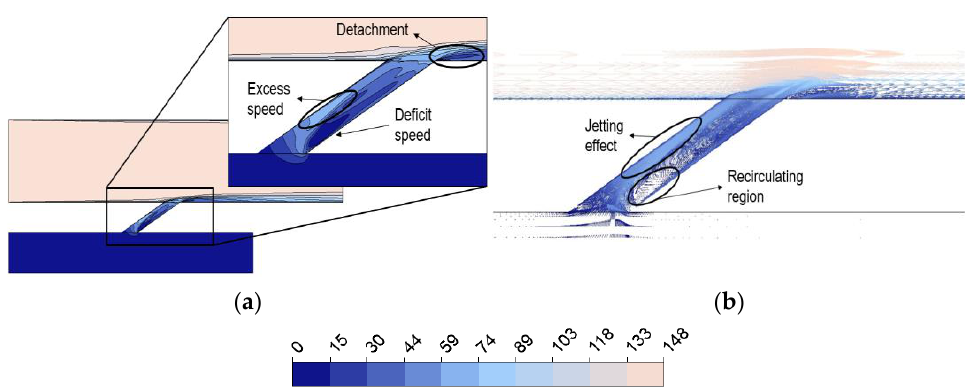
Figure 7. Numerical validation.